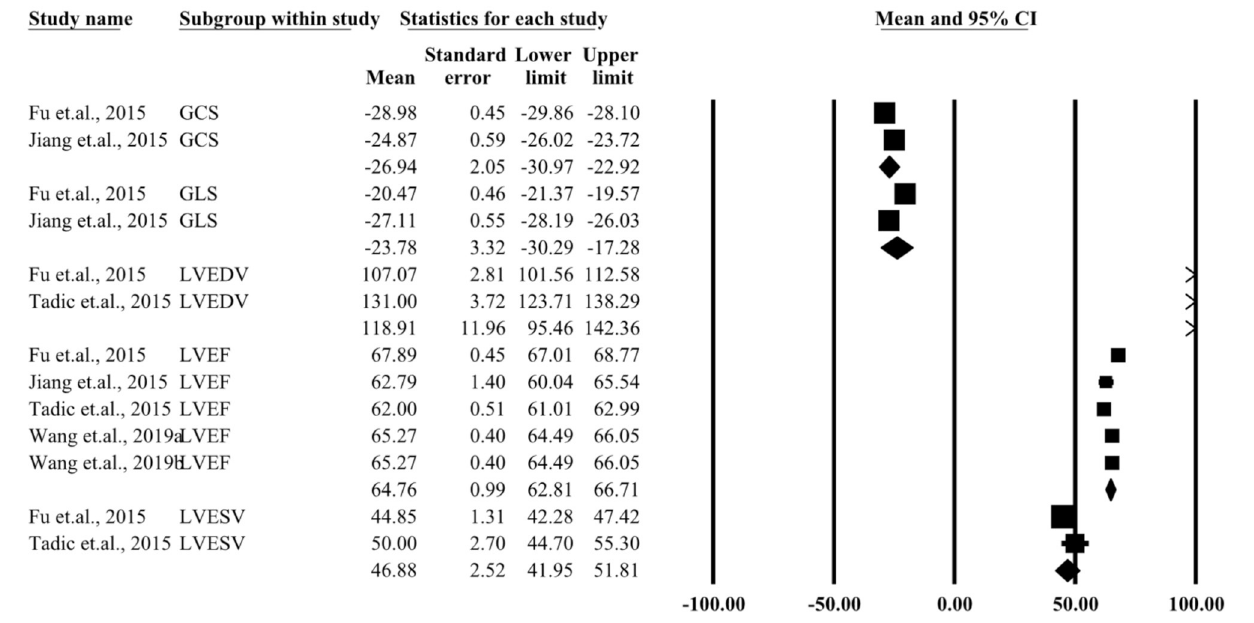
FIGURE 4 | Summary of three-dimensional echocardiographic parameters for the left ventricular control group.